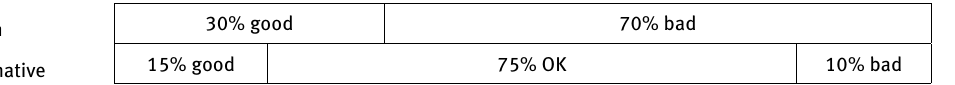
Fig. 4: Polarized distribution of Dutch sailors; “uneven” distribution of int’l